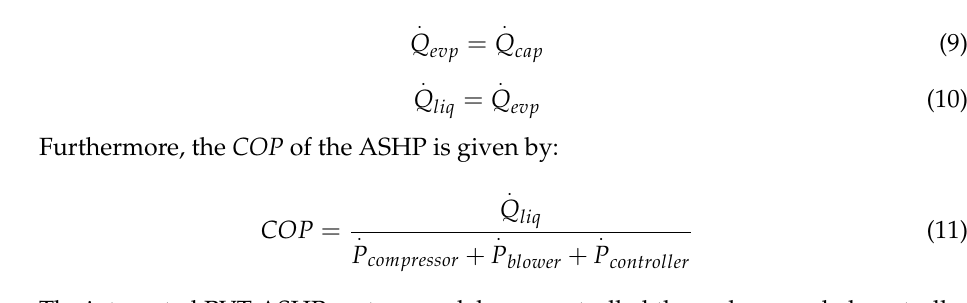
tank reached 45 °C. The PVT module could maintain the DHW tank temperature at more than 40 °C from 1 – 5 PM. In the cooling season, the PVT module could supply hot water to the DHW tank, at a temperature approximately 20 °C higher than that of the heating season. However, the PVT module could not meet the hot water temperature standard (60 °C), recommended by ASHRAE to prevent Legionella pneumophila [26]. Therefore, a low-capacity auxiliary heat source or heat pump for heat storage is required to response the hot water temperature standard. Figure 8a,b show the electrical performance of the PVT module on the representative heating and cooling days. The daily total electrical production of the PVT module was 7.7 and 22.5 kWh in the heating and cooling seasons, respectively. The average electrical efficiency in the heating and cooling seasons were 14.1 and 13.3%, respectively. In the cooling season, the temperature of the PVT module significantly increased owing to the high outdoor temperature (Figure 8). The increase in the temperature of the PVT module caused a reduction in electrical efficiency, however, exhibiting a large difference in electrical production, since the duration of sunlight was three hours longer in the cooling season than in the heating season.